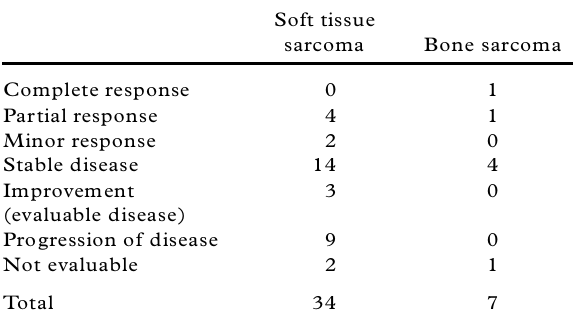
Table 3. Response